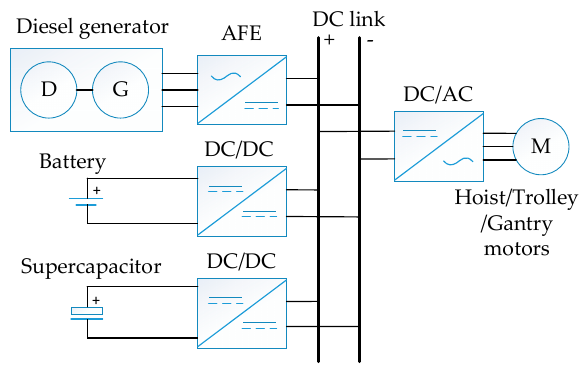
Figure 1. Schematic of the hybrid system.